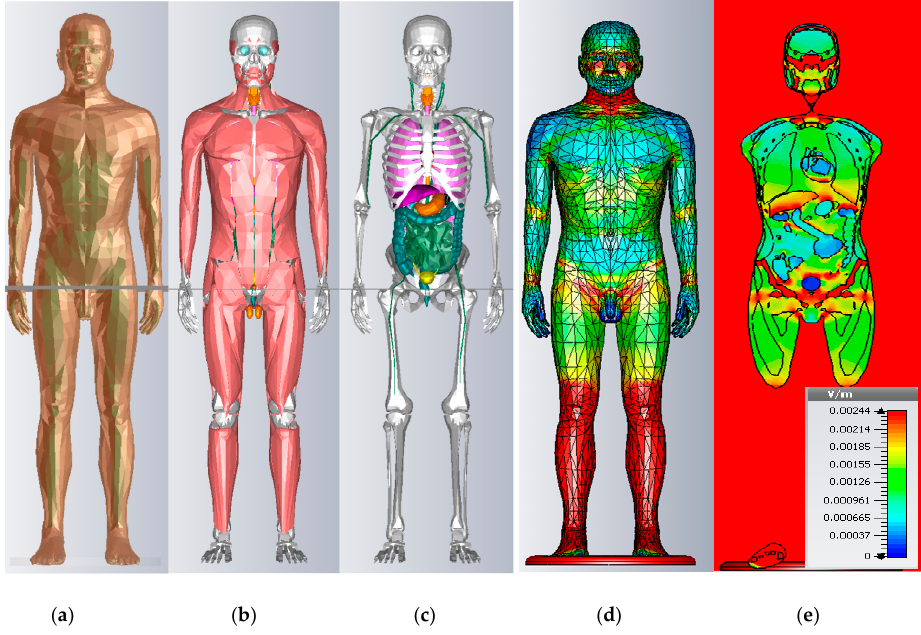
Figure 1. Human body model images at a resolution of 2 mm from left to right, respectively, ( a ) the skin is visible (left), ( b ) the skin and fat layers have been hidden and ( c ) the muscle layer has been hidden to show the internal organs (middle); Electric field induced on the model under 1 kV/m 50 Hz, ( d ) whole body in 3D and ( e ) coronal view (right).